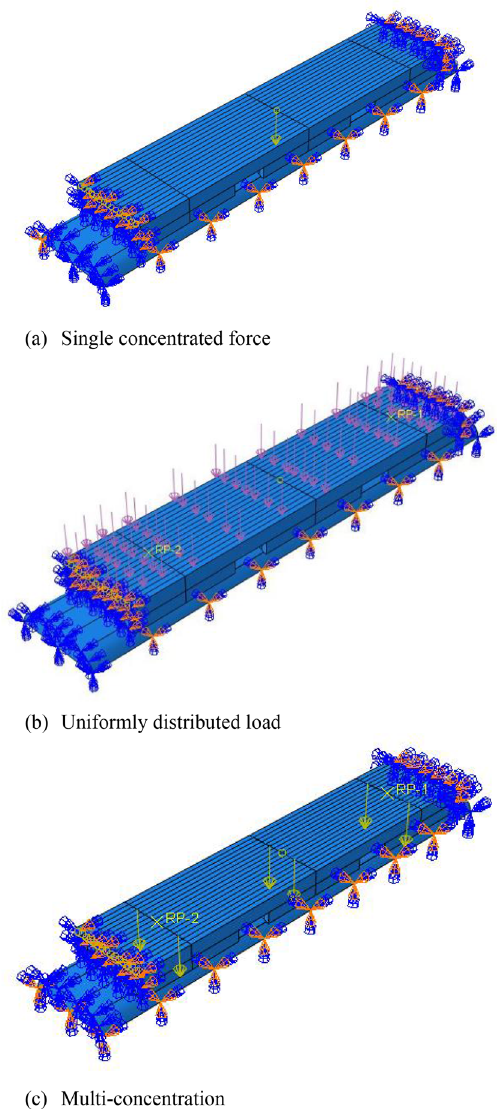
Figure 5 Different load modes on contact force: a Single concentrated force; b Uniformly distributed load; c